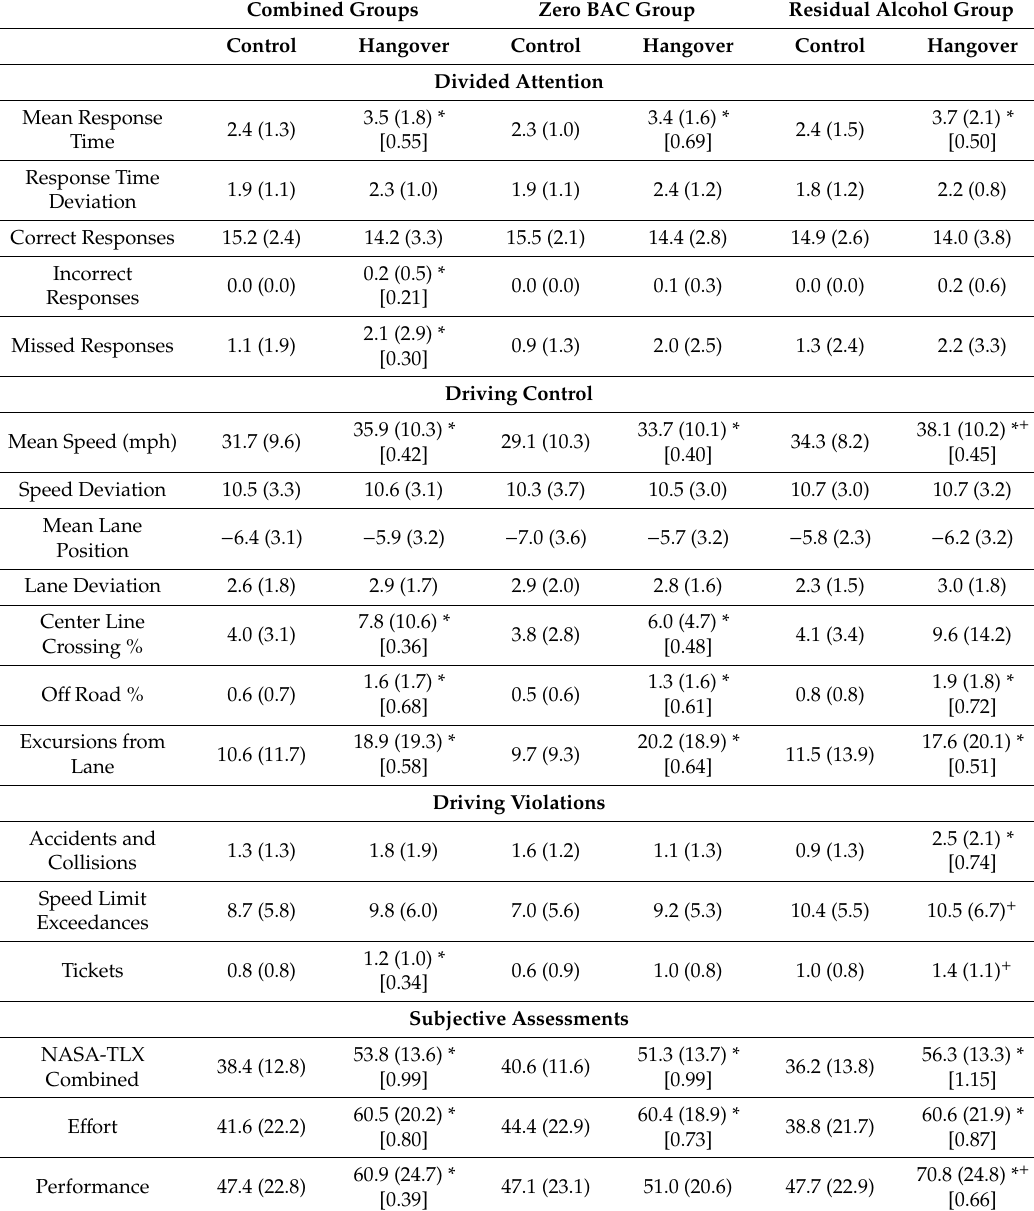
Table 1. Driving Performance and Subjective Measures: Means